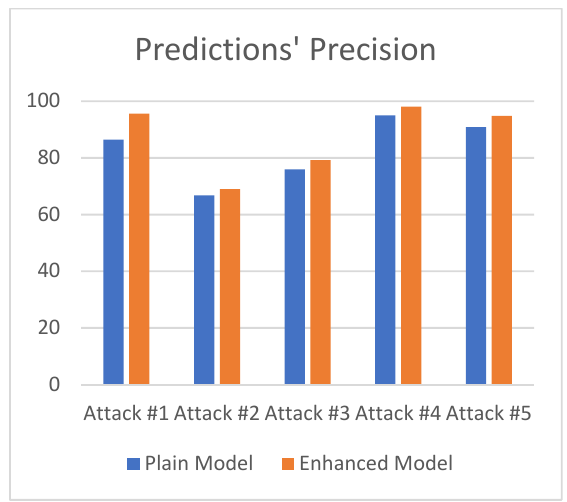
Figure 4. Precision of predictions for both IDSs for all attacks. Table 3. Confusion matrix for enhanced dataset.